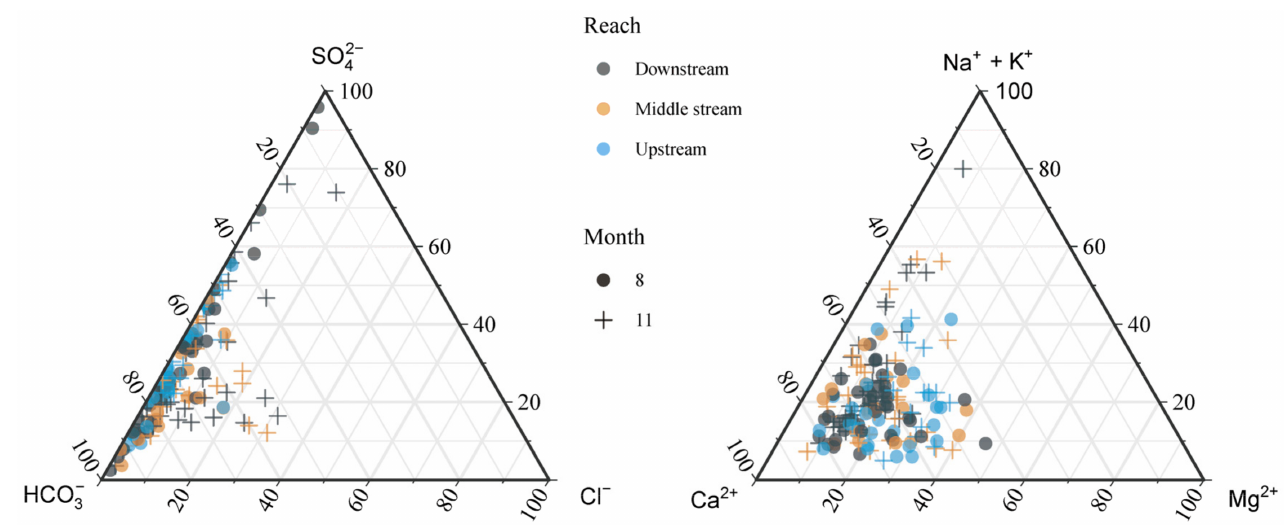
Figure 2. Ternary diagram of water samples in the LR during the rainy season and the dry